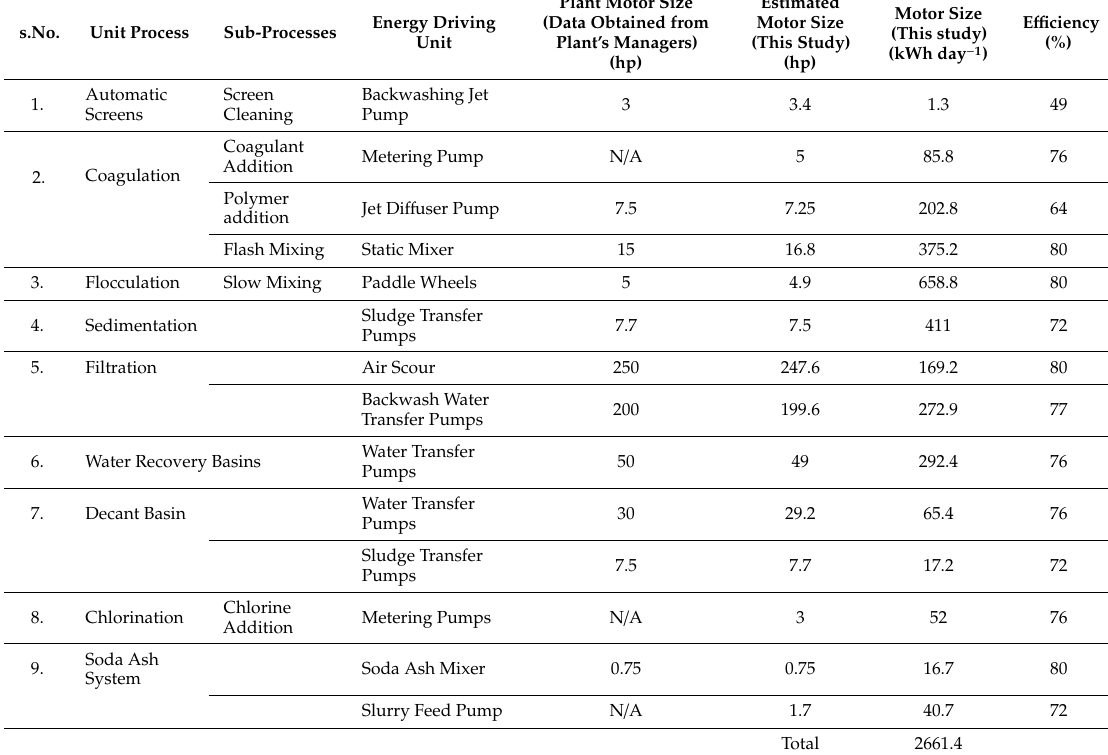
Table 5. Results for the estimation of energy consumption for the various unit processes of the drinking water treatment plant (Scenario